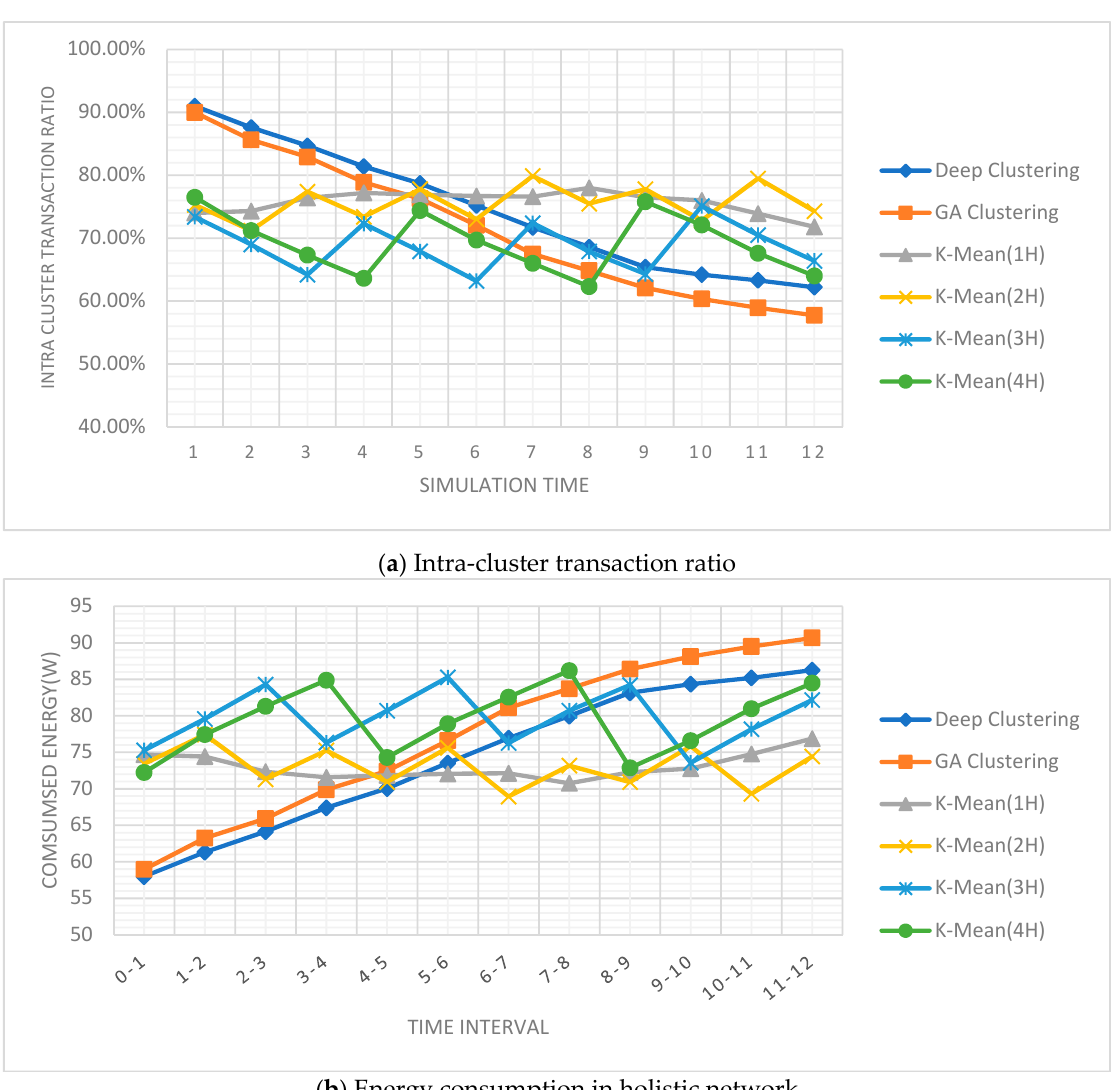
Figure 7. Performance of proposed deep clustering in lightweight IoT blockchain network.